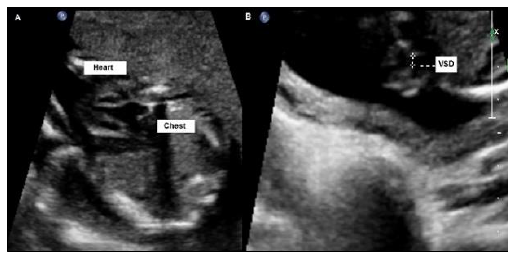
Figure 1: A. Axial plan of the fetal thorax showing ectopia cordis. B. Axial plan of the fetal thorax showing ventricular septal defect.